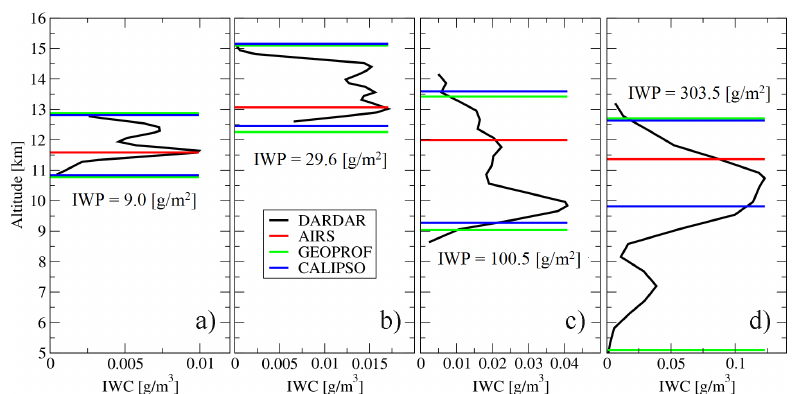
Figure 2. Examples of the IWC profiles of high ice clouds, including information on cloud height from the collocated AIRS-LMD, CALIPSO, GEOPROF, and DARDAR data, for clouds with increasing IWP values. Black curves: DARDAR IWC( z ) profile; coloured horizontal lines mark the position of the AIRS cloud, CALIPSO and GEOPROF cloud top and cloud base heights. All profiles are for July 2007: (a) lat = 2.3 ◦ , lon =− 15.9 ◦ ; (b) lat = 23.9 ◦ , lon = 101.7 ◦ ; (c) lat = 0.3 ◦ , lon = 101.8 ◦ ; (d) lat =− 2.5 ◦ , lon = 120.6 ◦ .